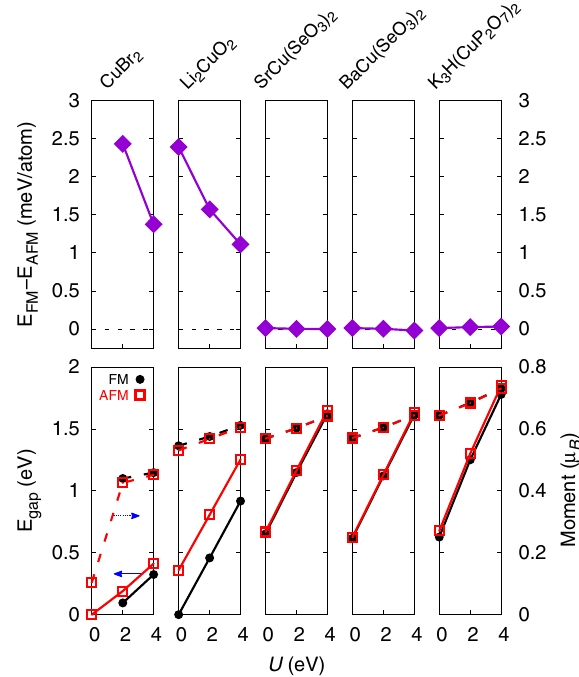
FIG. 4. Impact of electronic correlations via DFT þ U on the electronic and magnetic properties of the identified materials. The relative energetics of ferromagnetic (FM) and antiferromagnetic (AFM) states, electronic band gap, and local Cu magnetic moment as a function of correlation strength U are shown for the subset of five candidate